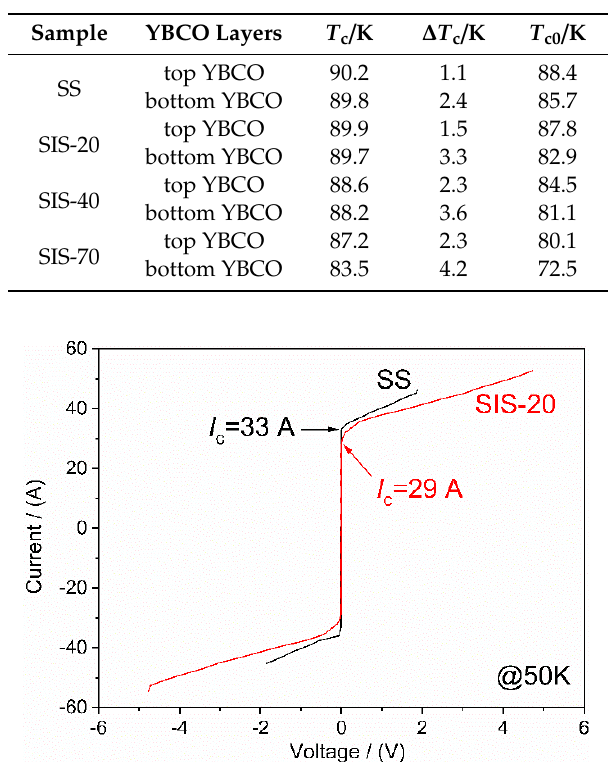
Figure 5. I–V curves of the YBCO/YBCO (SS) trilayer and YBCO/LAO/YBCO (SIS-20) trilayer films with the LAO interlayer thickness of 20 nm.